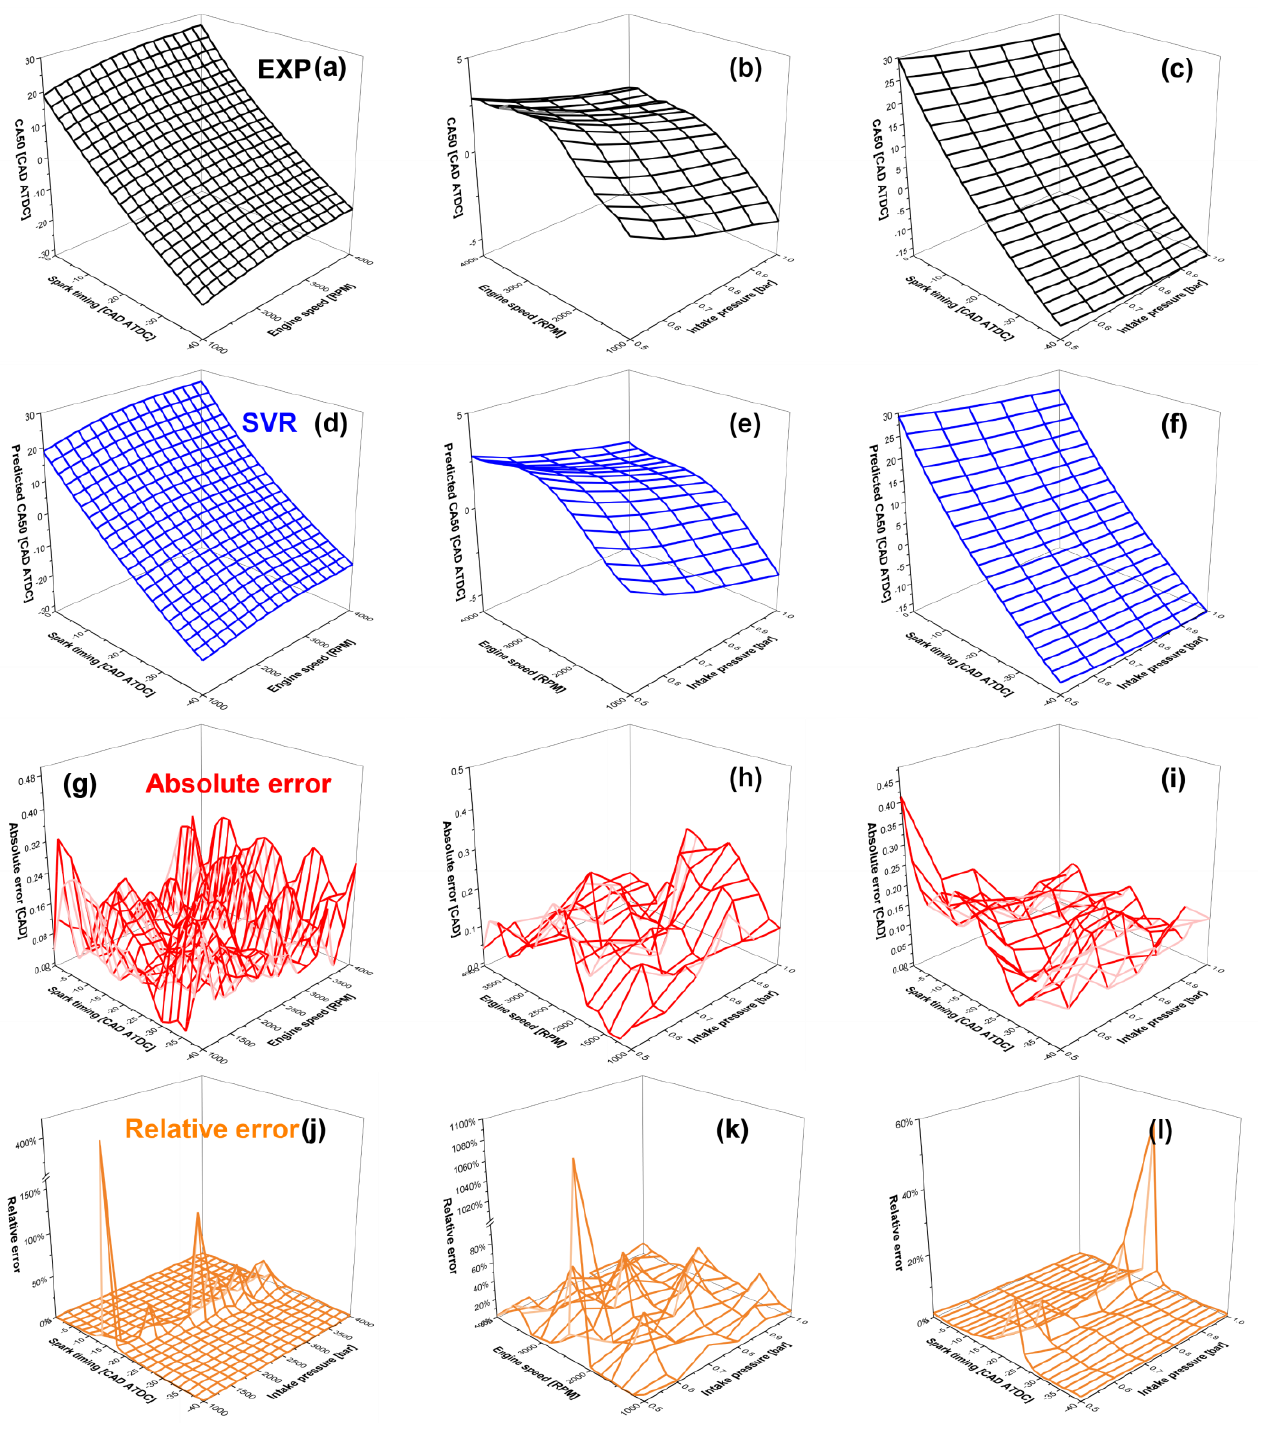
Figure 15. CA50 versus different operation parameters combination. ( a , d , g , j ) Prediction performance when spark timing and engine speed change (intake pressure = 1 bar); ( b , e , h , k ) prediction performance when engine speed and intake pressure change (spark timing = − 20 CAD ATDC); and ( c , f , i , l ) prediction performance when spark timing and intake pressure change (engine speed = 2600 RPM).